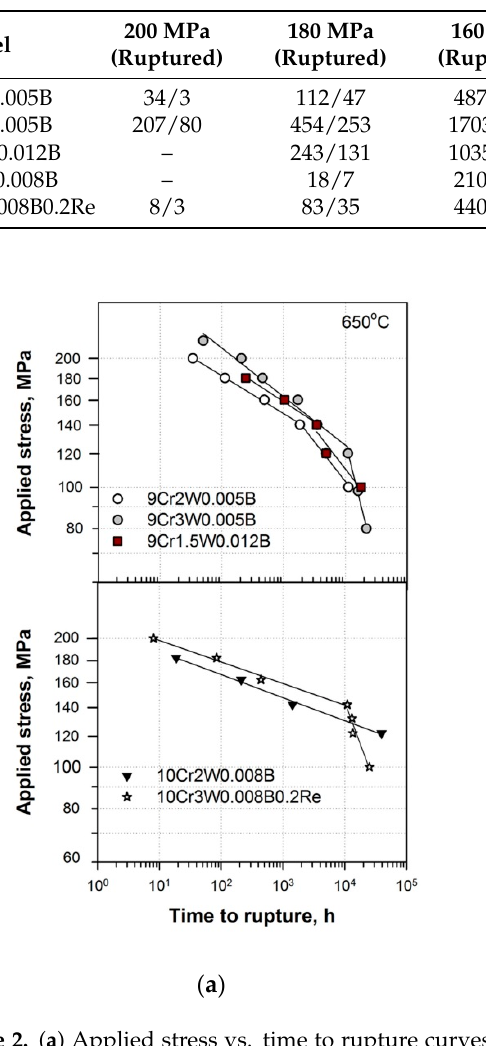
Table 3. Effect of applied stresses on rupture time (numerator) and off-set time (denominator), at which minimum creep rate is achieved, and an information on durations of interrupted creep tests at 650 °C (in hours). Steel